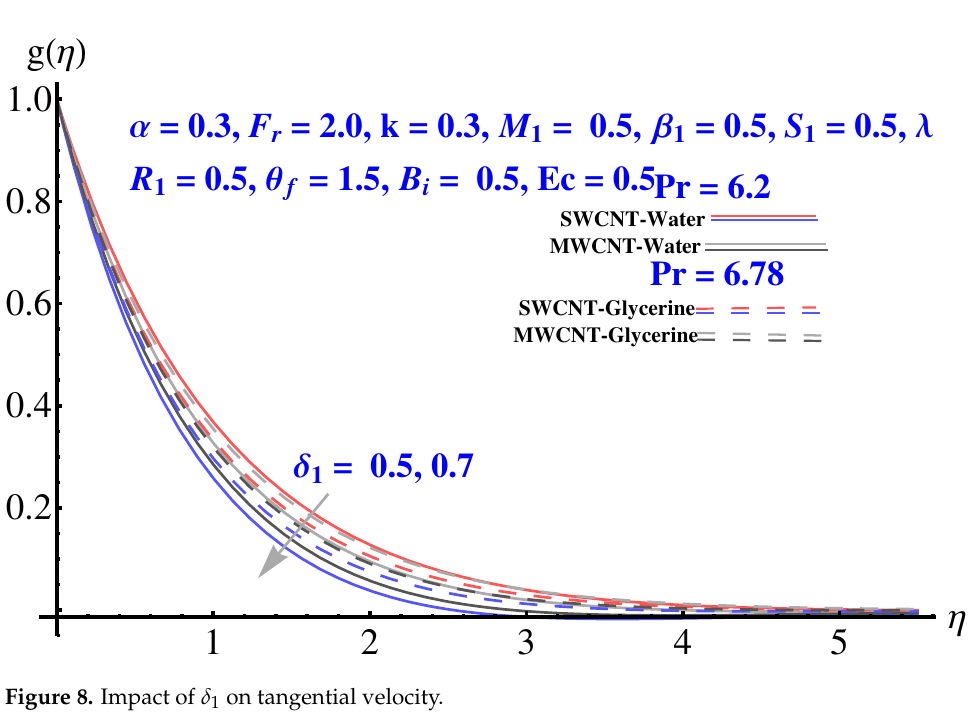
Figure 7. Impact of β 1 on tangential velocity.